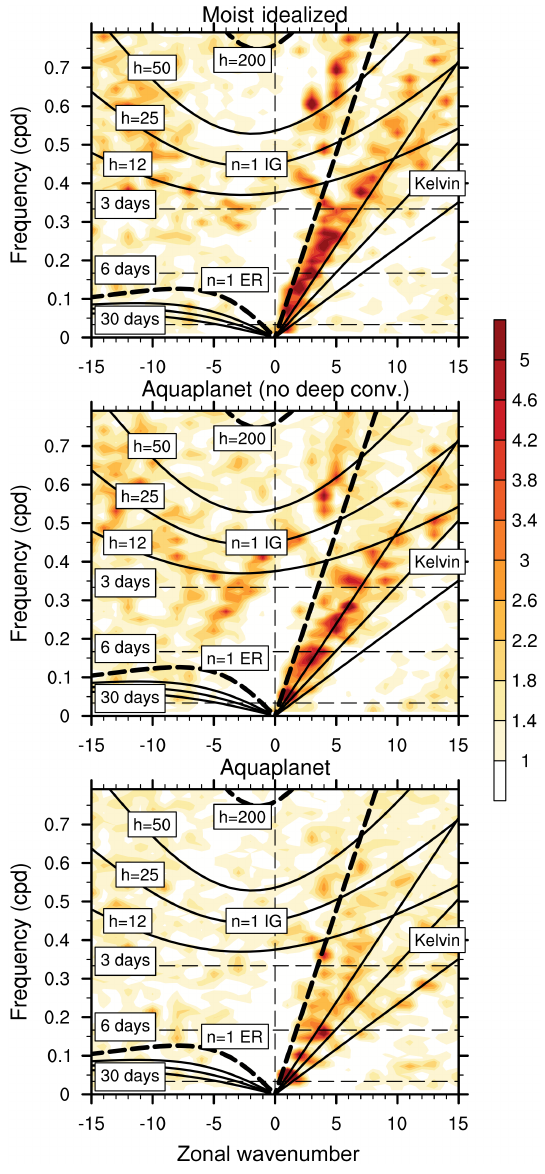
Figure 7. Wavenumber–frequency diagrams for CAM5-SE show- ing spectral power for the symmetric component of the 100hPa equatorial temperature averaged between ± 15 ◦ in the (a) MITC, (b) APS (NDC), and (c) APS simulations. The solid lines show the theoretical shallow-water dispersion curves for the equivalent depths h = 12 , 25, and 50m without a mean background velocity. The thick dashed line is the h = 200m dispersion